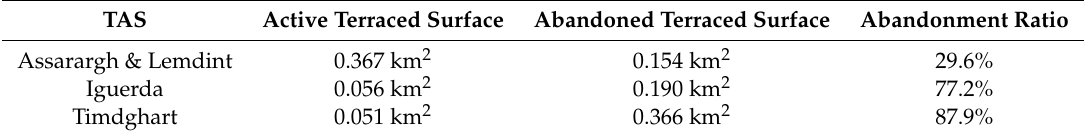
Table 2. Abandonment ratio of terraced surface in the three terraced agroecosystems (TAS), calculated as percentage of abandoned terraced surface to the whole TAS surface. The terraces’ state is the one observed in 2019, as a diachronic comparison was not feasible. The surfaces have been measured contouring polygons manually, on a satellite imagery base, the results have been validated by a field